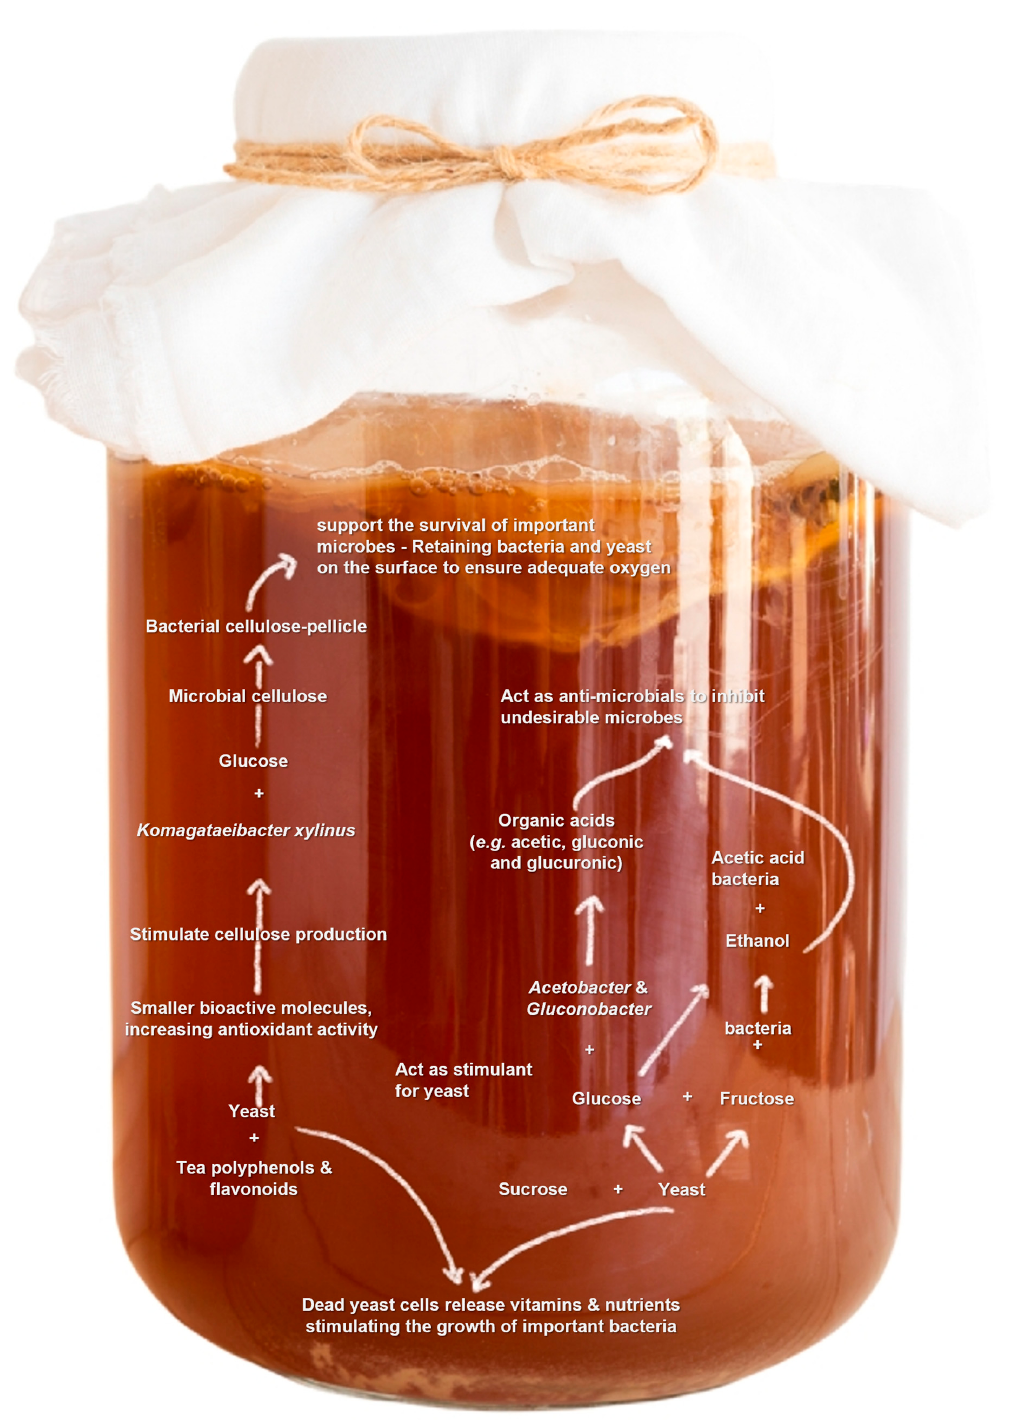
Figure 2. An illustration of the metabolic interplay and functional compatibility of kombucha fermentation microbiota, representing a model for the adaptation and symbiosis of the microbiota in the fermentation